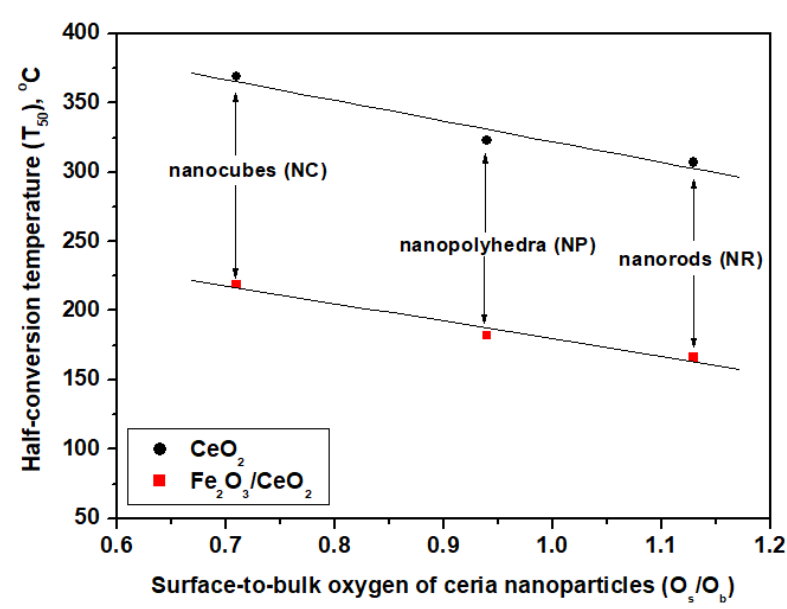
Figure 9. Relationship between the half-conversion temperature (T 50 ) and the surface-to-bulk oxygen ratio (O s /O b ).